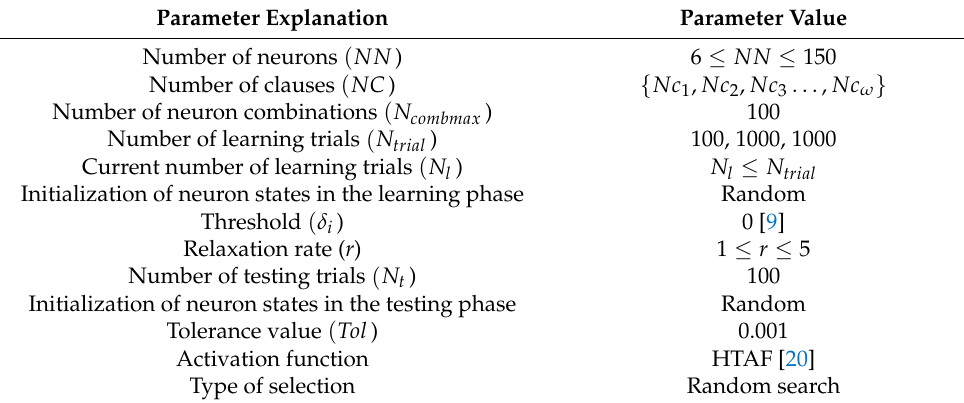
Table 1. Parameters for the proposed GRAN3SAT.